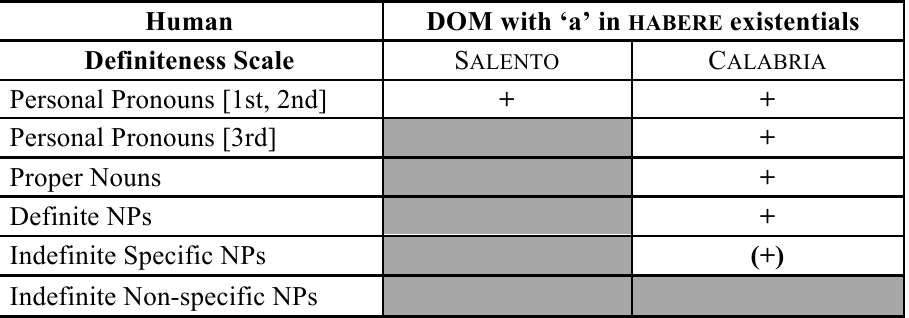
Table 1: Definiteness Scale and Differential Object